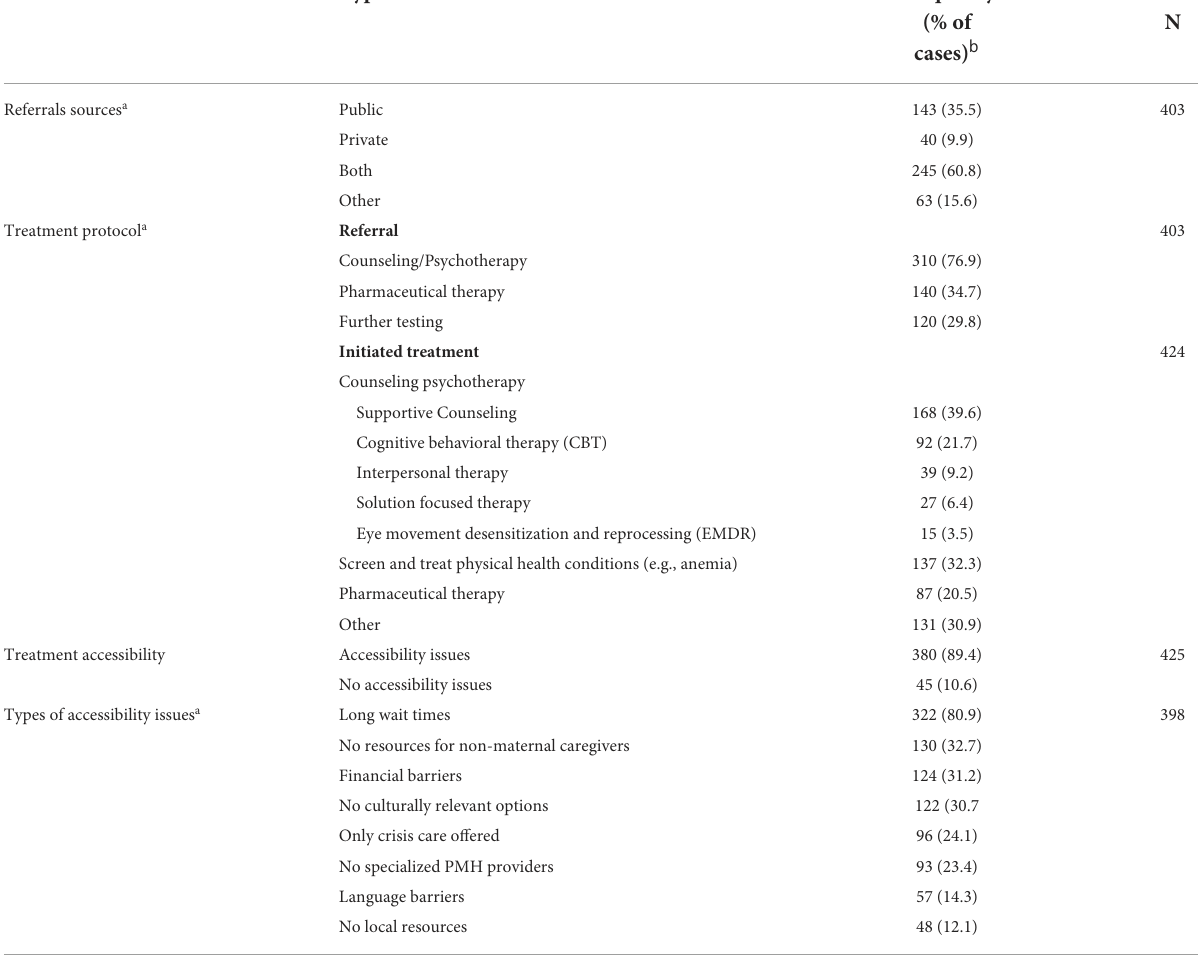
TABLE 3 Management for positive screens for mental health concerns reported by